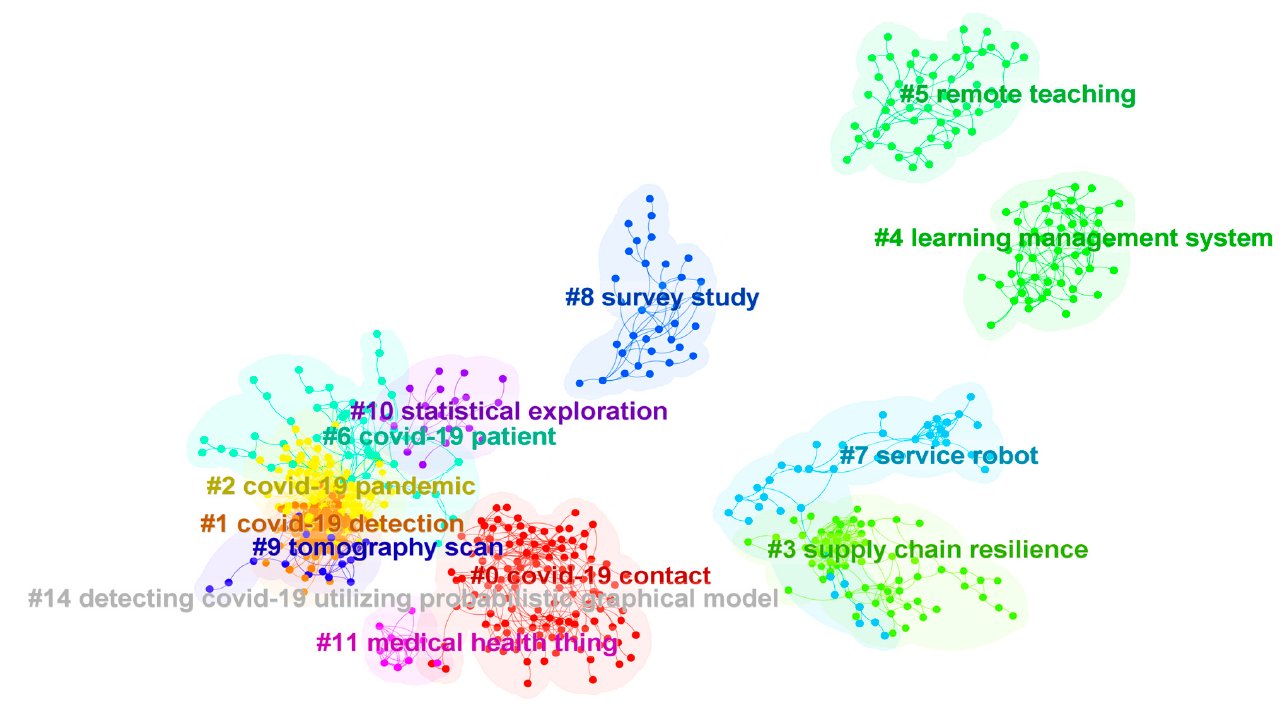
Figure 6. Literature co-citation network (cluster view). This figure corresponds to Figure 5 and omits the labels of all nodes, which aims to highlight the clustering categories. Every category label has a color, and the boundary of the category is presented.